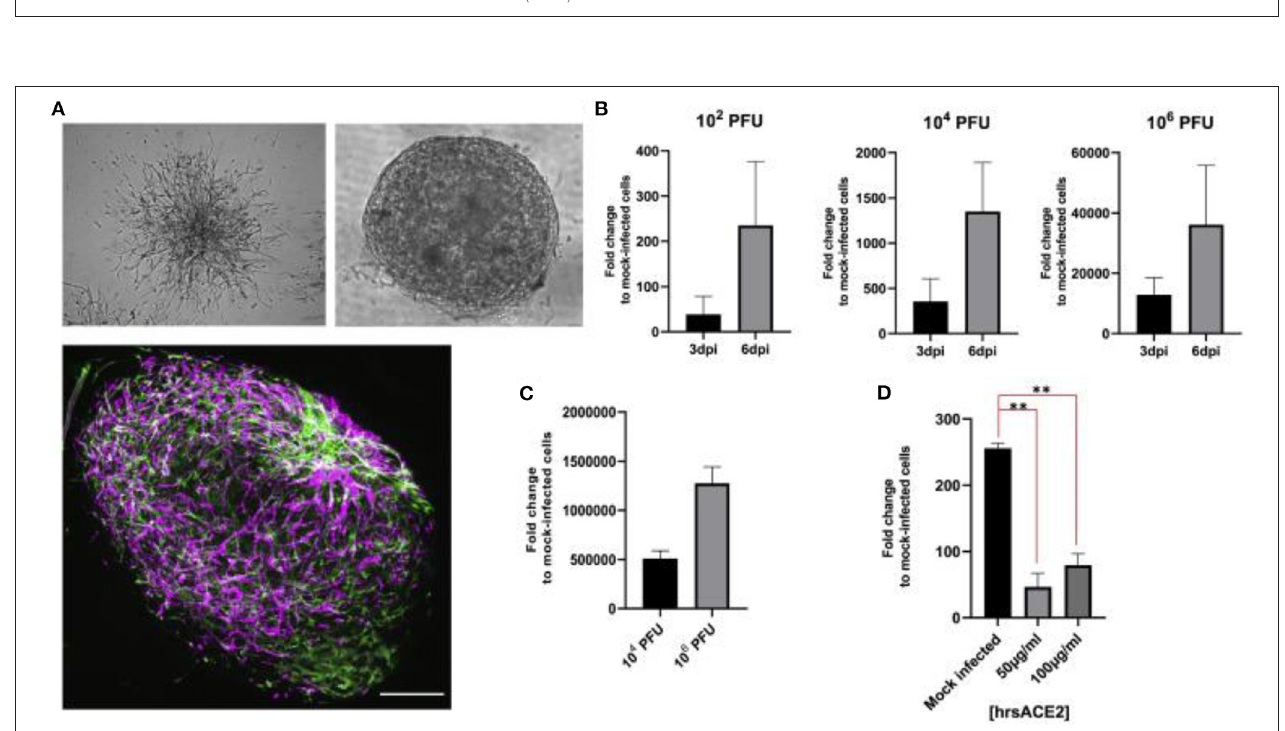
FIGURE 4 | (A) Vascular capillary organoids imaged using light microscopy (upper) and blood vessel organoids using imaged with immunostaining to detect endothelial cells and pericytes (lower). (B) Viral RNA recovered from organoids at day 3 and 6 after SARS-CoV-2 infection. (C) The supernatant from SARS-CoV-2 infected organoids 6 days after infection were used to infect Vero E6 cells. (D) Effect of hrsACE2 on vascular organoids infected with SARS-CoV-2 after organoids were infected with 10 6 infectious particles and hrsACE2 for 1h 3 days after SARS-CoV-2 infection. Results were measured using qPCR. Scale bars are 500 and 50mm. This figure is reprinted under the terms of the Creative Commons Attribution License from Monteil et al. (2020). ** indicates a significant difference between the conditions.